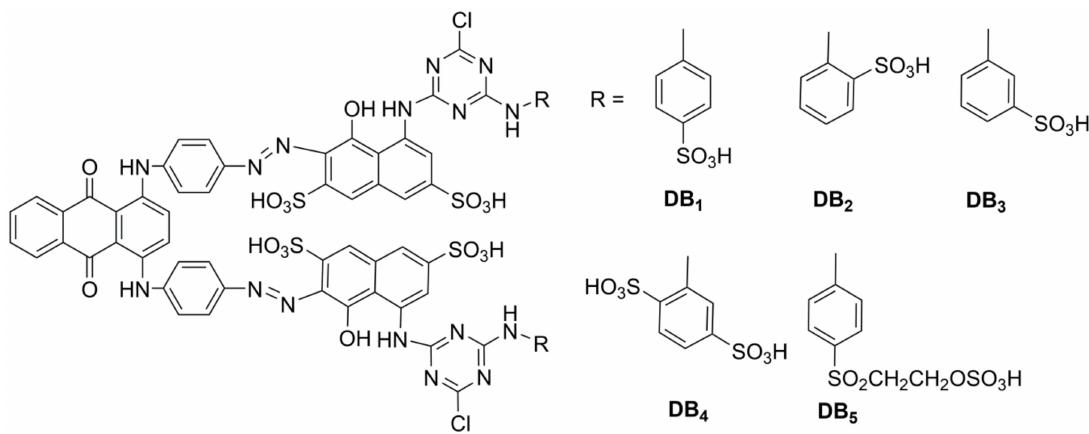
Figure 1. Structures of azo-anthraquinone reactive dyes.